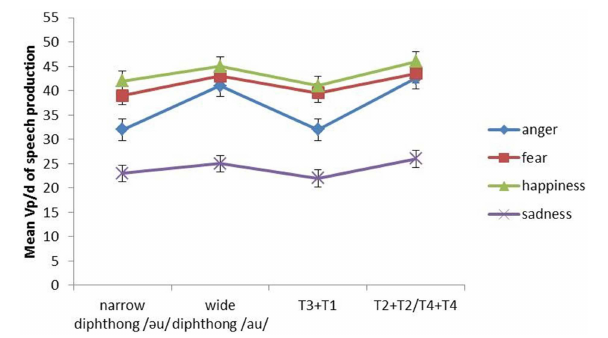
TABLE 8 | Results of the Three-Way repeated-measures ANOVA on articulation dynamics (as reflected by Vp/d). F Df P η 2 p FIGURE 8 | The mean Vp/d of narrow diphthong, wide diphthong, T3 + T1 and T2 + T2/T4 + T4 in the four types of emotional speech (anger, fear, happiness, and sadness). Error bars represent the standard error of the